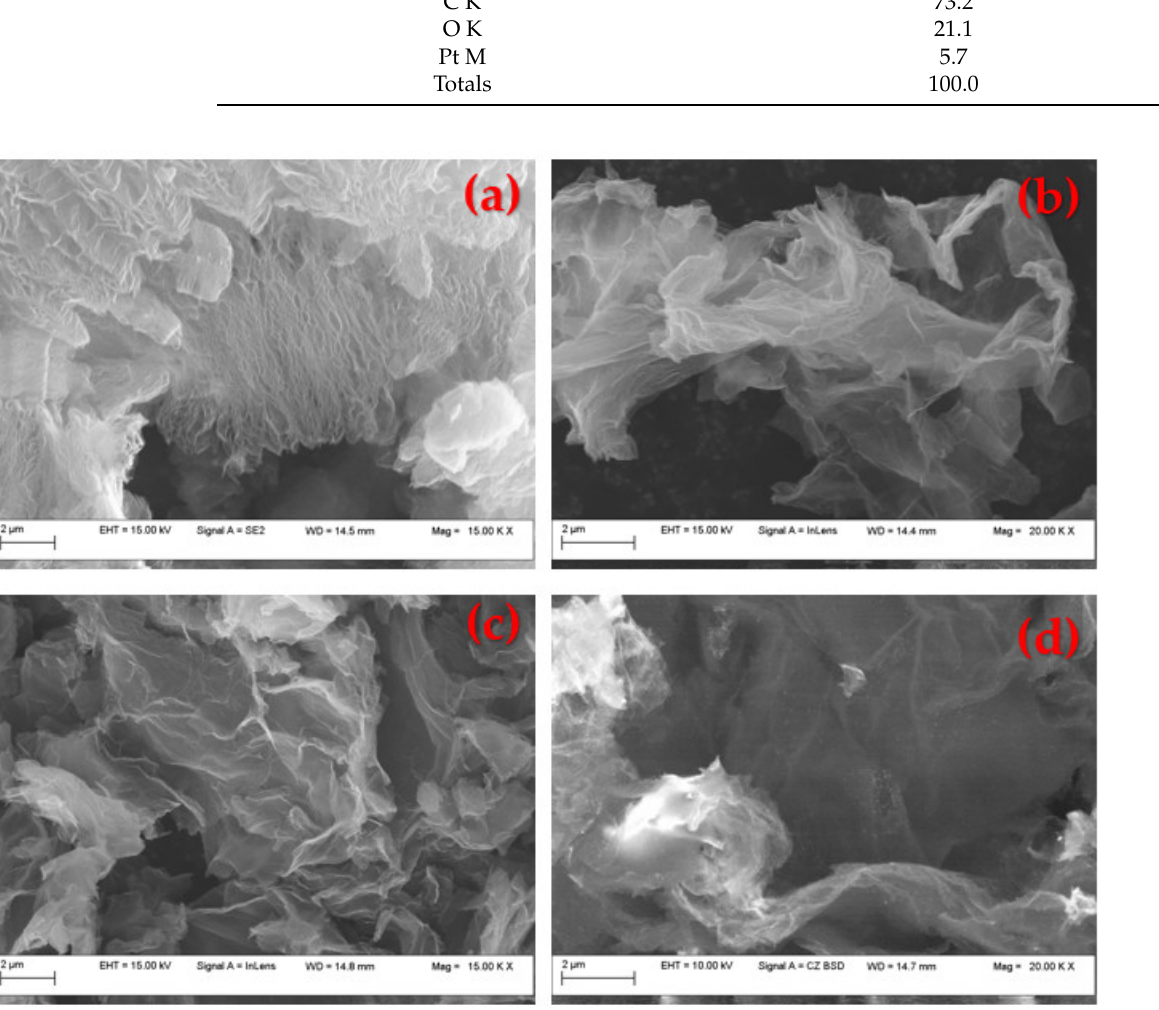
Table 2. The total elemental composition of PtrGO3 determined by EDX, corresponding to Figure 1d [34].